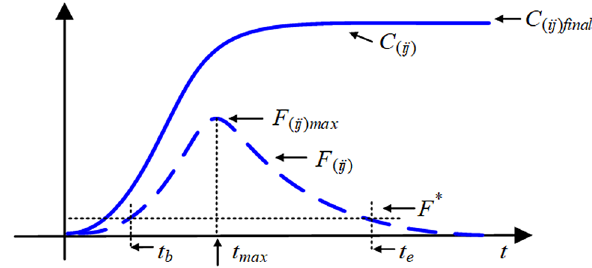
Figure 9. Some summative indices of the public hot